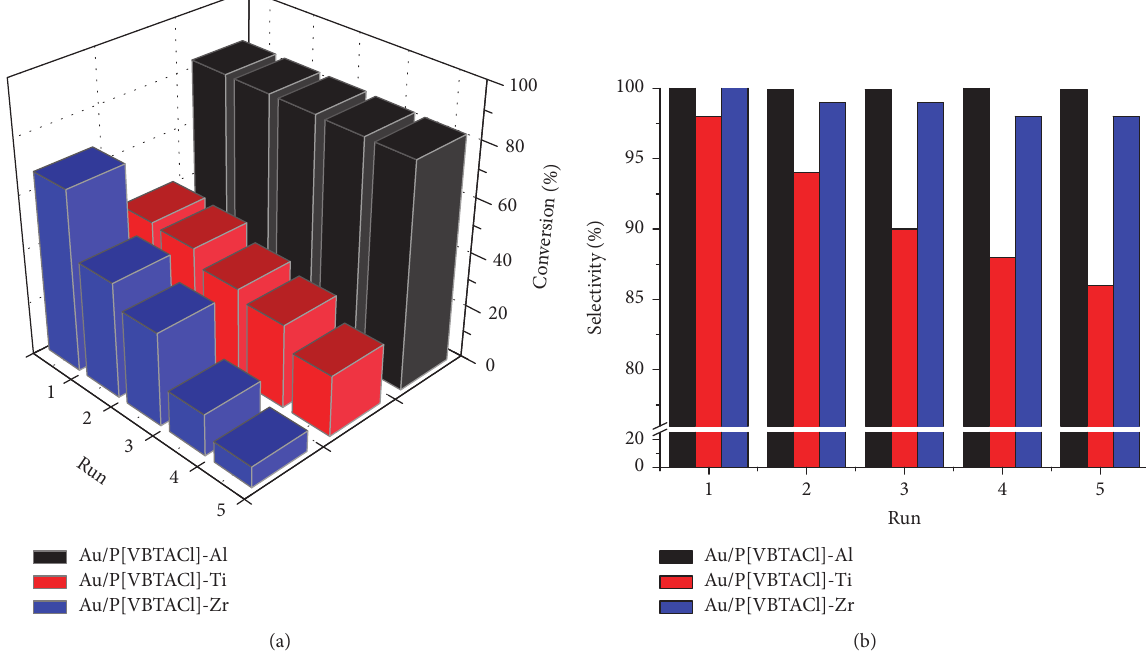
Figure 5: Conversion level (a) and selectivity (b) versus number of reaction cycles during the m-CNB hydrogenation over Au/P[VBTACl]/M catalysts. Reaction conditions: p-CNB concentration: 0.02 mol L −1 , catalyst mass: 0.070 g, P absolute ethanol. N-(p-chlorophenyl)hydroxylamine-intermediary was the only byproduct detected.